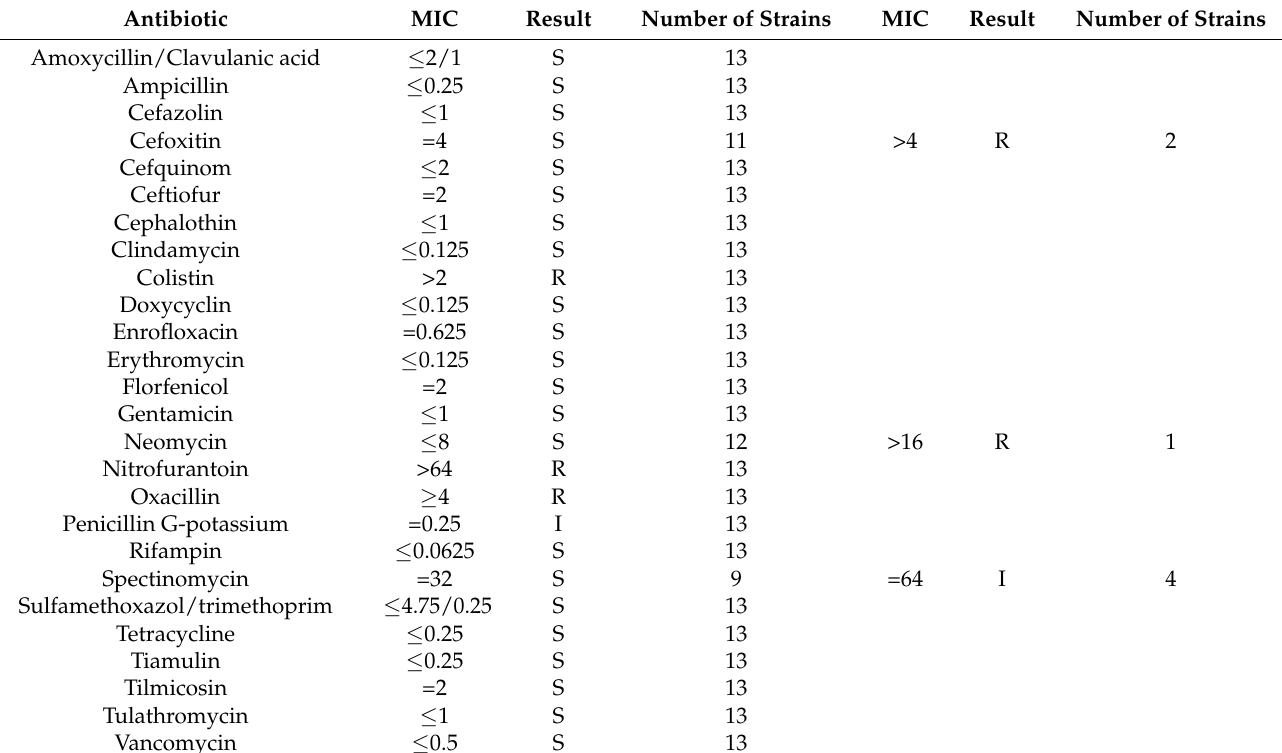
Table 4. Determination of minimal inhibitory concentration (MIC) values (mg/L) for C. pseudotuber- culosis isolates using the broth microdilution method carried out in microtiter plates. Evaluation